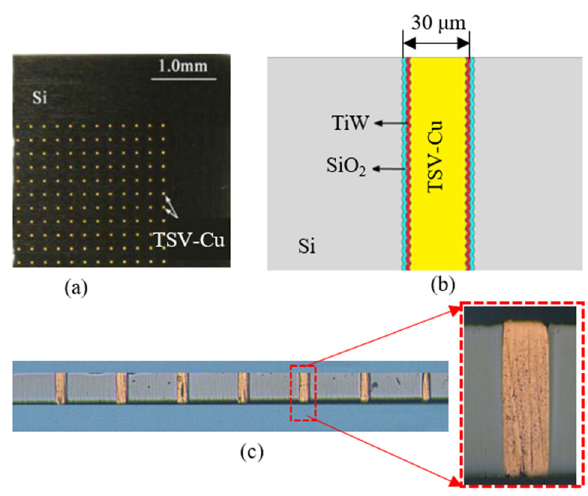
Figure 1. Schematic diagram of the TSV sample: ( a ) the TSV-Cu array; ( b ) cross-section of TSV-Cu; ( c ) polished axial cross-section of TSV-Cu.